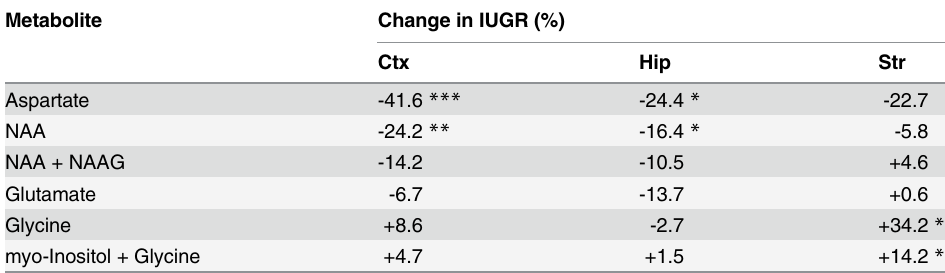
GLM (adjusting by brain temperature and estimated tissue contribution to voxel) * p <